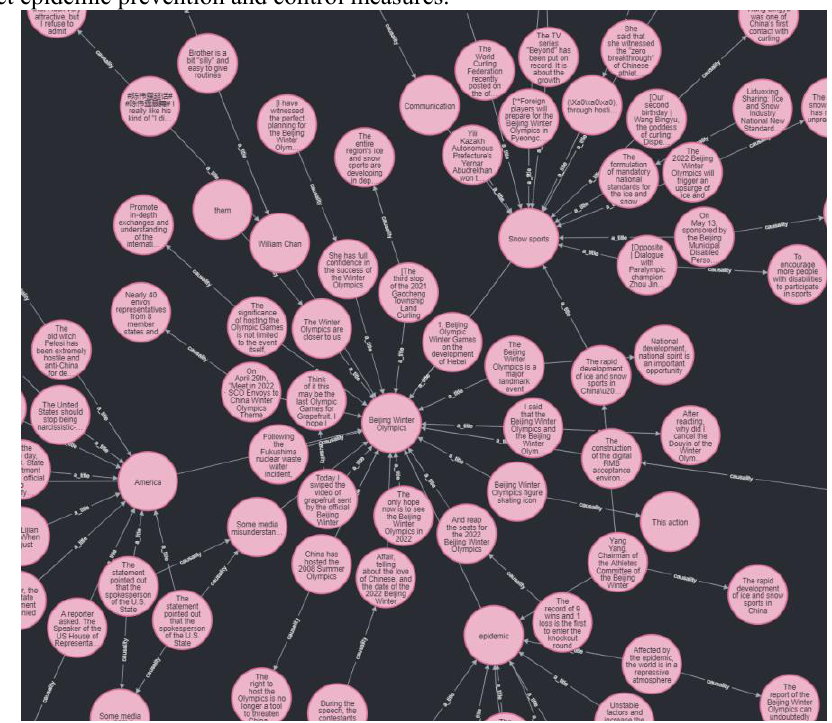
Fig. 9. Overall graph of Microblog netizens from April to